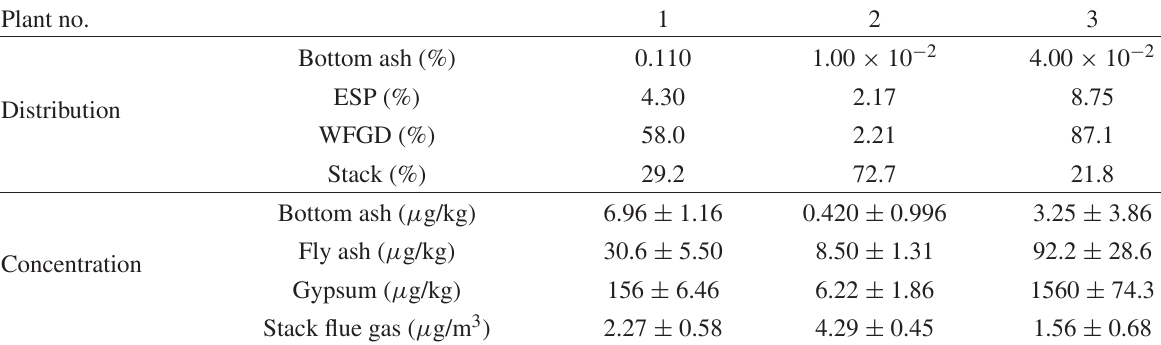
TABLE 7: Relative distribution of Hg and the mean concentrations of Hg in solid/gas samples in three power plants ( n = 3 ).